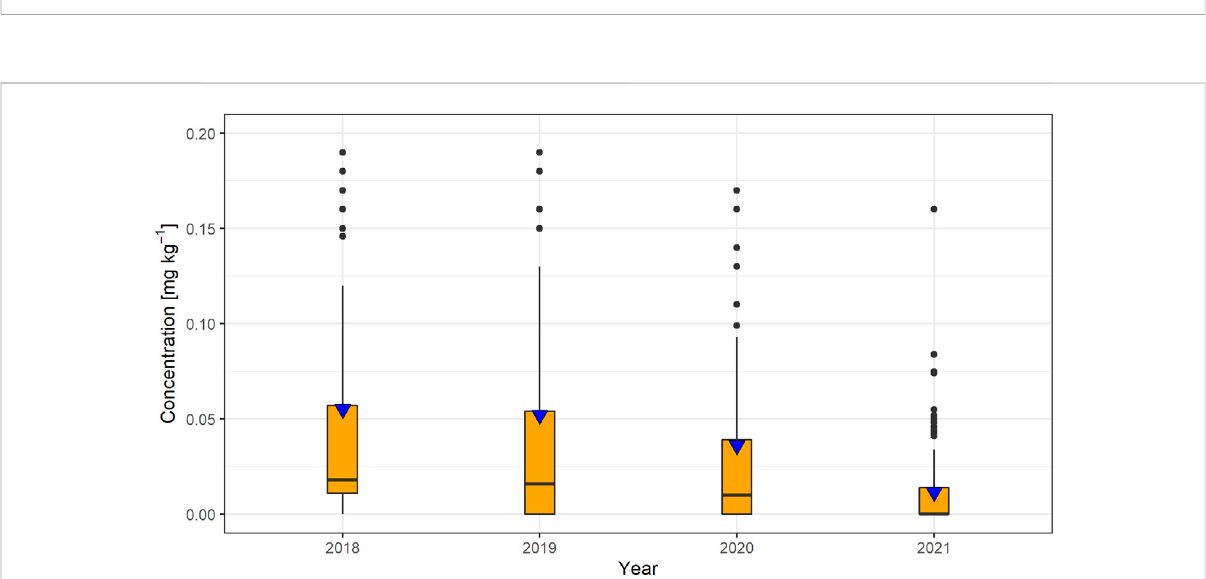
FIGURE 6 Residue concentrations per year. The boxes include all detected concentrationfor all active agents, sites, and sampling dates within 1 year.The blue triangle represents the mean concentration per year (over all sites and sampling dates). For statistics see Table 4. The residue concentration refers to the fresh weight of